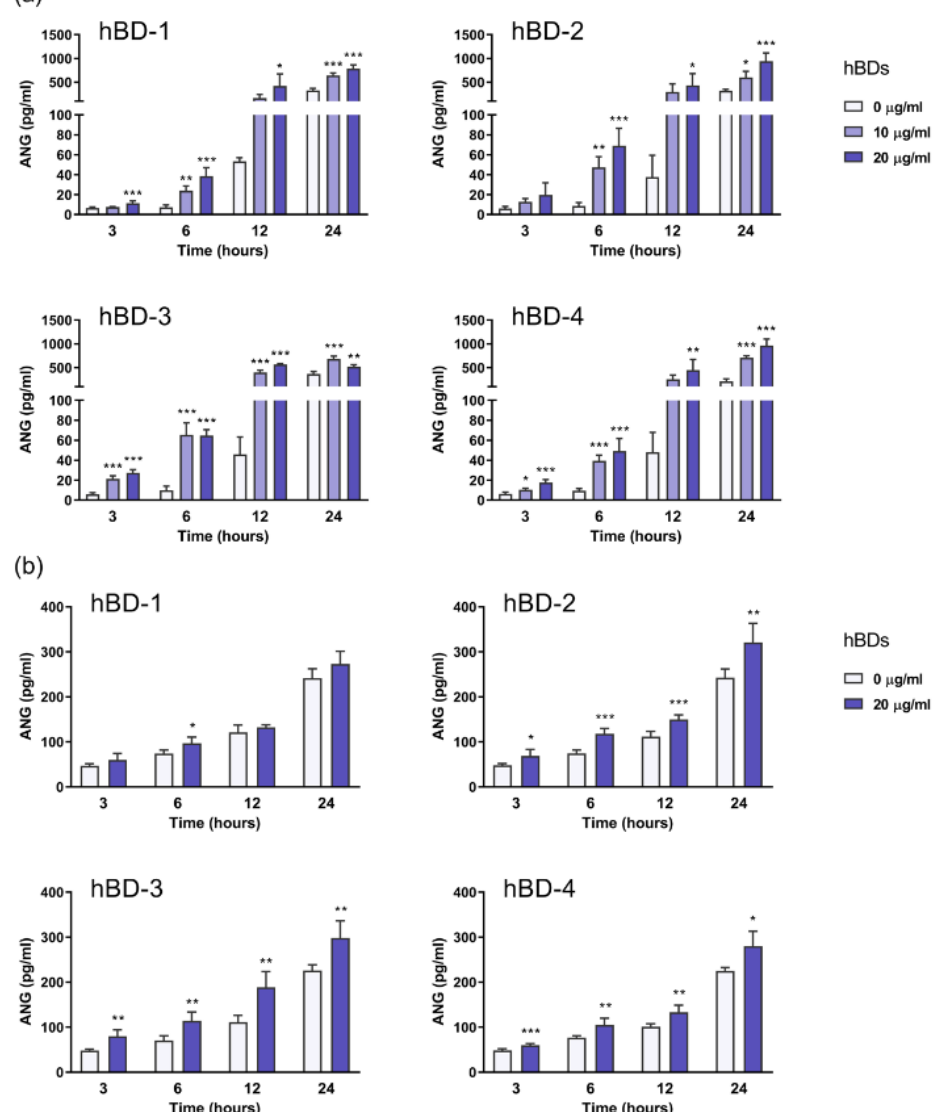
Figure 1. hBDs induce the secretion of the angiogenic factor ANG by human dermal fibroblasts. ( a ) Normal human dermal fibroblasts were stimulated with 10–20 μ g/mL hBDs or vehicle (0 μ g/mL hBDs) for 3–24 h, and the amounts of ANG in the culture supernatant were determined by ELISA. ( b ) Normal human dermal fibroblasts were cultured in a three-dimensional context using type I collagen gels and then stimulated with 20 μ g/mL hBDs or vehicle (0 μ g/mL hBDs) for 3–24 h. The amounts of ANG in the culture supernatant were determined by ELISA. The data represent the means ± SDs of 4–5 separate experiments. * p < 0.05, ** p < 0.01, and *** p < 0.001 compared with the vehicle at each time point by one-way ANOVA with Tukey’s multiple comparisons